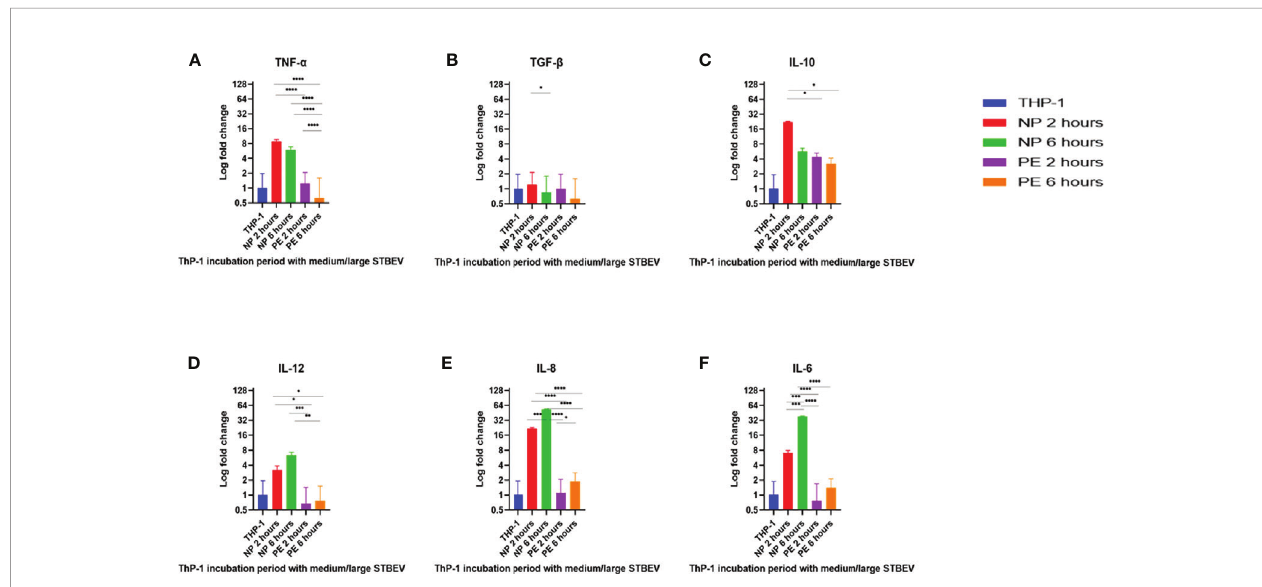
FIGURE 7 | RT-qPCR analysis of the medium/large STBEV induced expression of cytokines by differentiated ThP-1 cells. Cells were incubated with medium/large STBEVs from NP and PE placentae at 2 and 6 hour time-points. In control experiments, cells were incubated with fi ltered PBS at the same time-points. mRNA expression was measured using real-time RT-qPCR for medium/large STBEVs; TNF- a (A) , TGF- b (B) , IL-10 (C) , IL-12 (D) , IL-8 (E) and IL-6 (F) . Data were normalised to 18S rRNA expression that was used as an internal reference gene. Values calculated as mean ± SEM of value from cells treated with 1 X 10 9 of medium/large STBEVs. To determine signi fi cant difference in expression, one-way ANOVA was performed on data: *p ≤ 0.05, **p ≤ 0.01, ***p ≤ 0.001 and ****p <